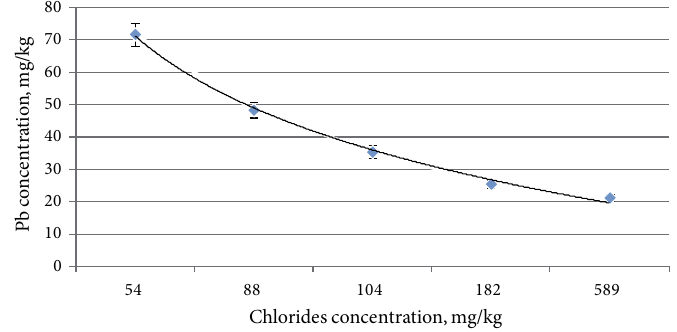
Fig. 3. Relationship between lead and chloride concentrations in sweep sand